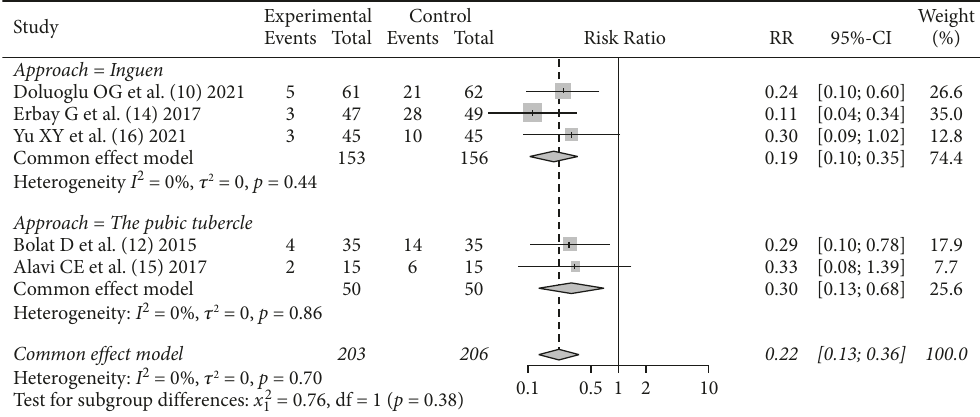
Figure 3: Comparison of the incidence of obturator nerve reflex between SA +ONB and SA alone in TURBT.